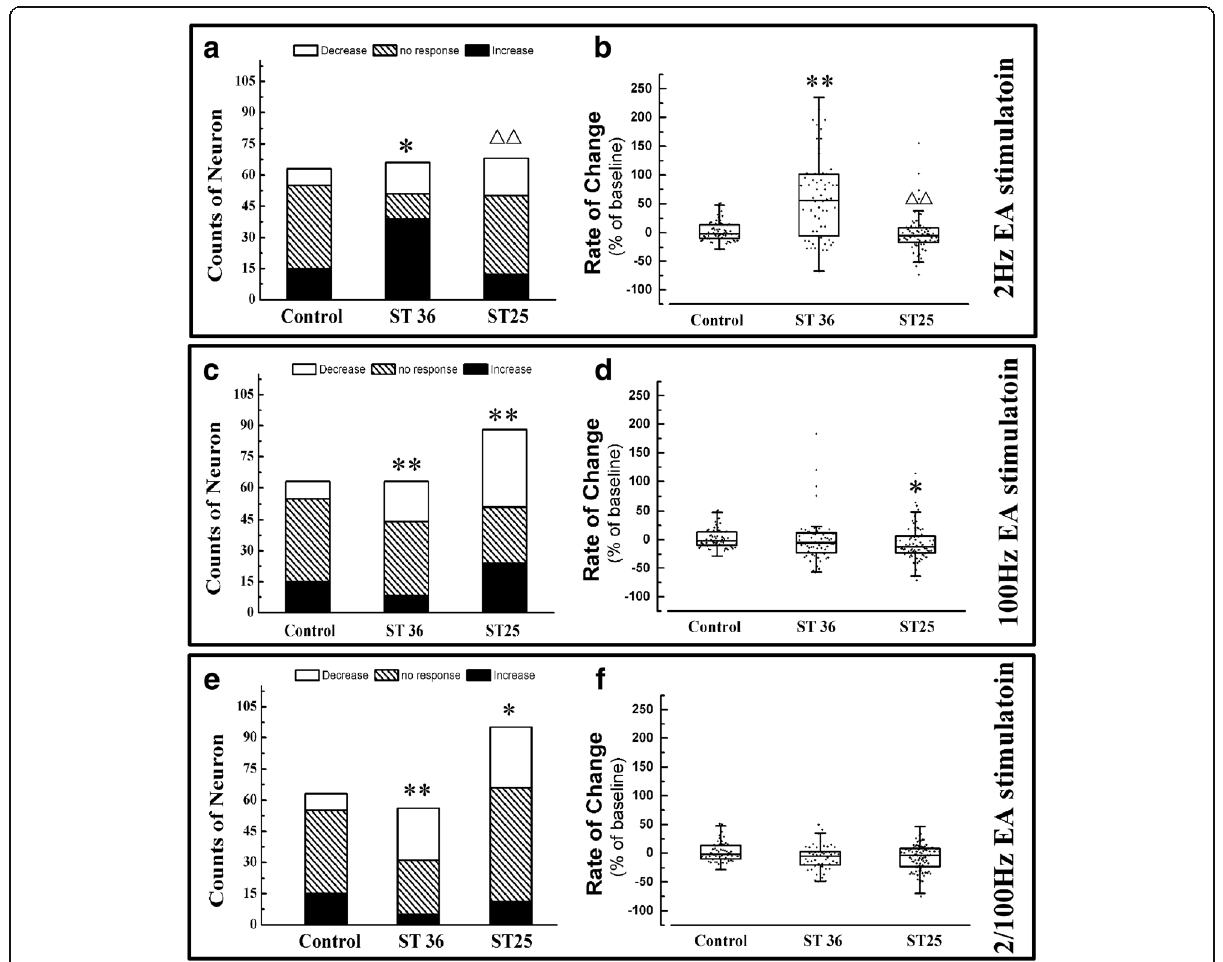
Fig. 3 The distribution of three types of neurons and the rate of change for spike frequency in NTS neurons after same EA frequency stimulated at ST 36 or ST 25. The population of three type neuron in NTS at 10 min after 2 Hz ( a ), 100 Hz ( c ) or 2/100 Hz ( e ) EA administrated. The change rates of spike frequency of NTS neurons at 9 min after 2 Hz ( b ), 100 Hz ( d ) or 2/100 Hz ( f ) EA administrated. Results of the counts of three types of neurons are real numbers and the rates of change of spike frequency are mean, quartile and standard deviation. n = 5. * P < 0.05, ** P < 0.01 versus control group, △ P < 0.05, △△ P < 0.01 versus ST 36